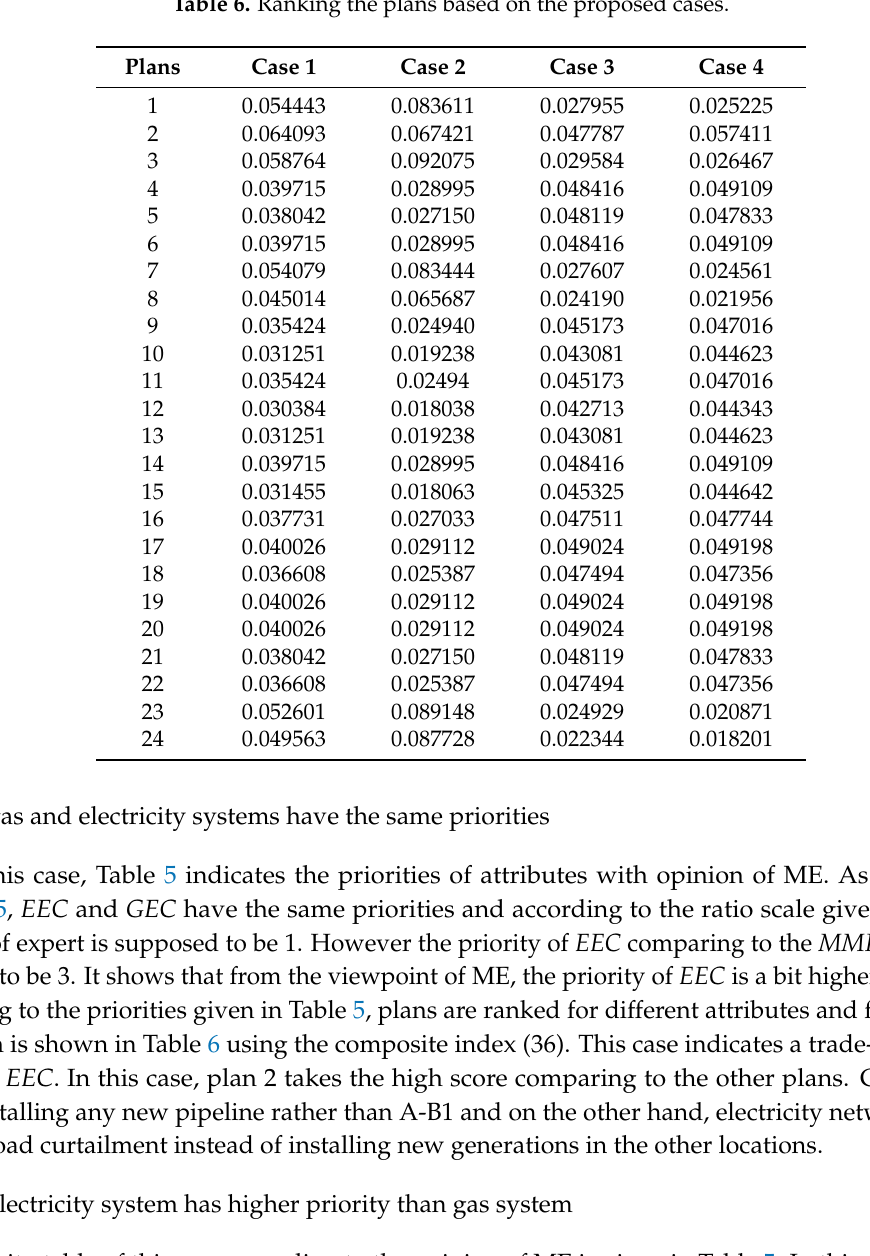
Table 6. Ranking the plans based on the proposed